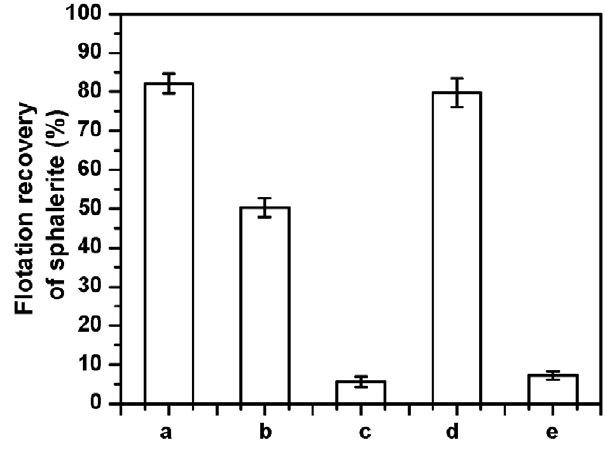
Figure 4. Effect of the strandedness of DNA on the flotation of sphalerite. a - thermolysed cell-free supernatant; b - genomic DNA (2 mg of dsDNA); c – DNase 1 treated genomic DNA; d - ssDNA (2 mg); e - DNase 1 treated